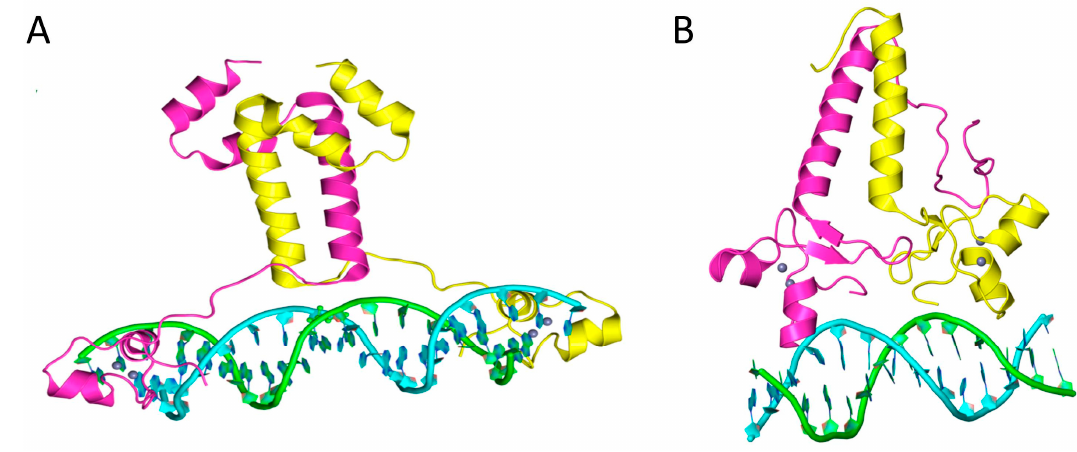
Figure 1. Structures of DNA-binding domains of zinc cluster proteins. ( A ) Crystal structure of the Gal4-DNA complex (PDB 1D66); and ( B ) crystal structure of the Ppr1 DNA-binding domain (PDB 1PYI). Both proteins form dimers. The two subunits are shown in yellow and pink. Grey spheres represent Zn 2+ ions.